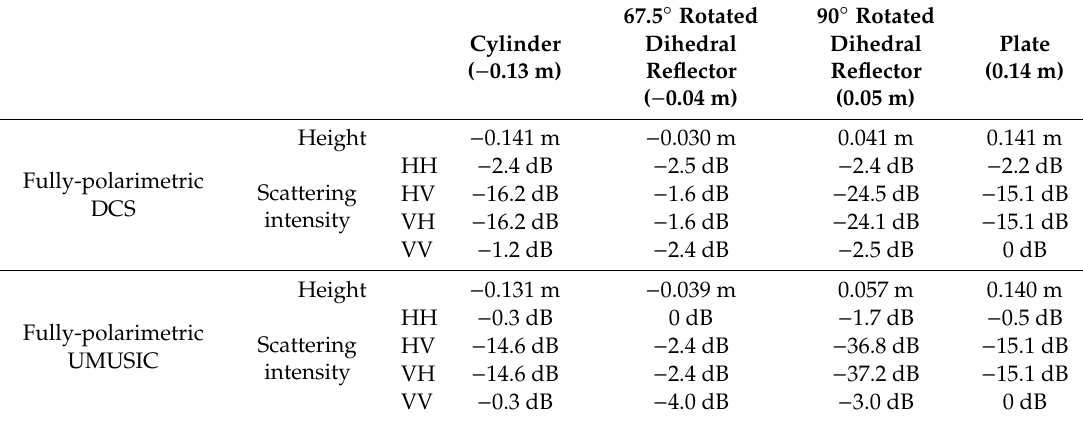
Figure 8. Aircraft model. ( a ) HH ( d ) VV Figure 9. Four 2D images obtained from a single baseline: ( a ) HH, ( b ) HV, ( c ) VH, and ( d ) VV. It can be seen from Figure 9 that the scattering mechanisms of the aircraft model are different in four polarizations. In the HH image, there are three strong scattering centers including two parts that are not distinguished (see Figure 9a). Compared with the HH image, more components can be distinguished from the VV image. The scattering intensity of the two cross-polarization images is low. Figures 10–13 illustrate the 3D point cloud maps obtained from 24 2D images. The top views are similar to the 2D image, which proves that the 3D scattering intensity can be estimated by LSM. It can be seen from the bottom and side views that scattering centers with different heights are basically consistent with the aircraft model. In addition, the scattering intensity in front of the fuselage is higher than that of the fuselage tail due to the shielding of the supporting foam. By comparing the 3D point cloud maps in different polarizations, we can analyze its scattering mechanism.